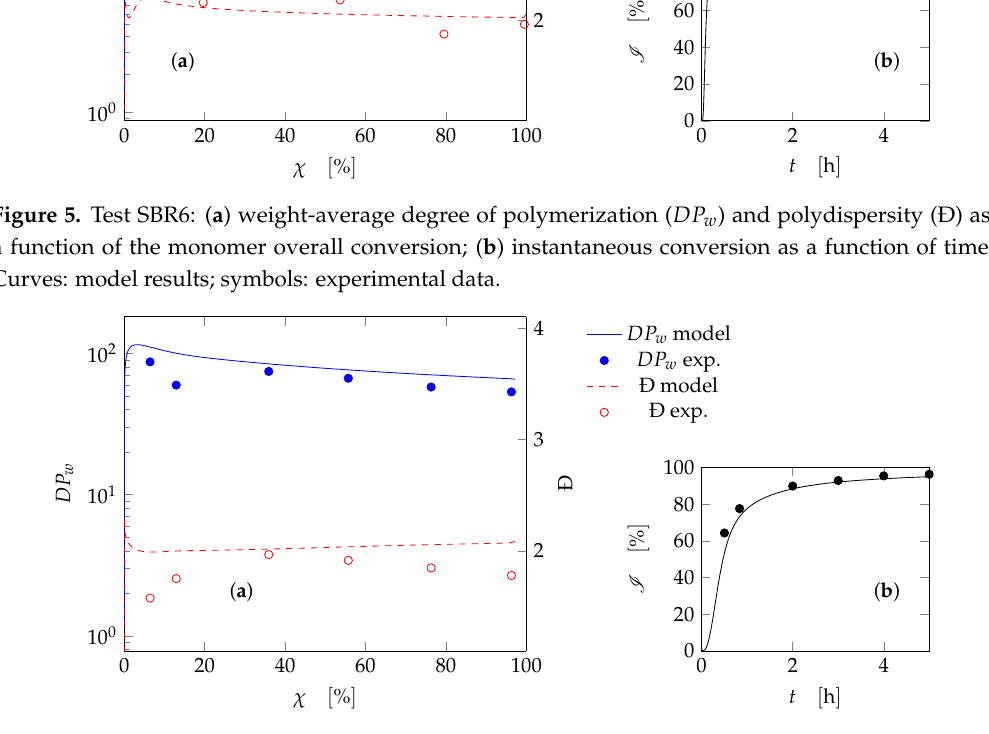
Figure 6. Test SBR7: ( a ) weight-average degree of polymerization ( DP w ) and polydispersity (Ð) as a function of the monomer overall conversion; ( b ) instantaneous conversion as a function of time. Curves: model results; symbols: experimental data.